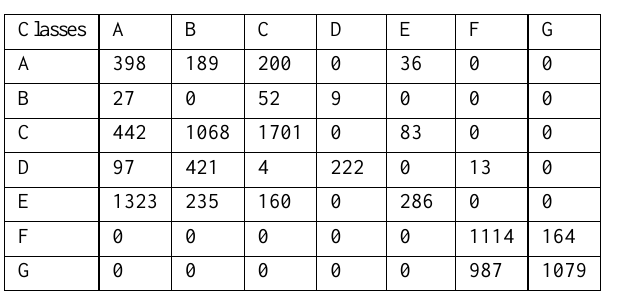
Table 7: Confusion matrix of SAM